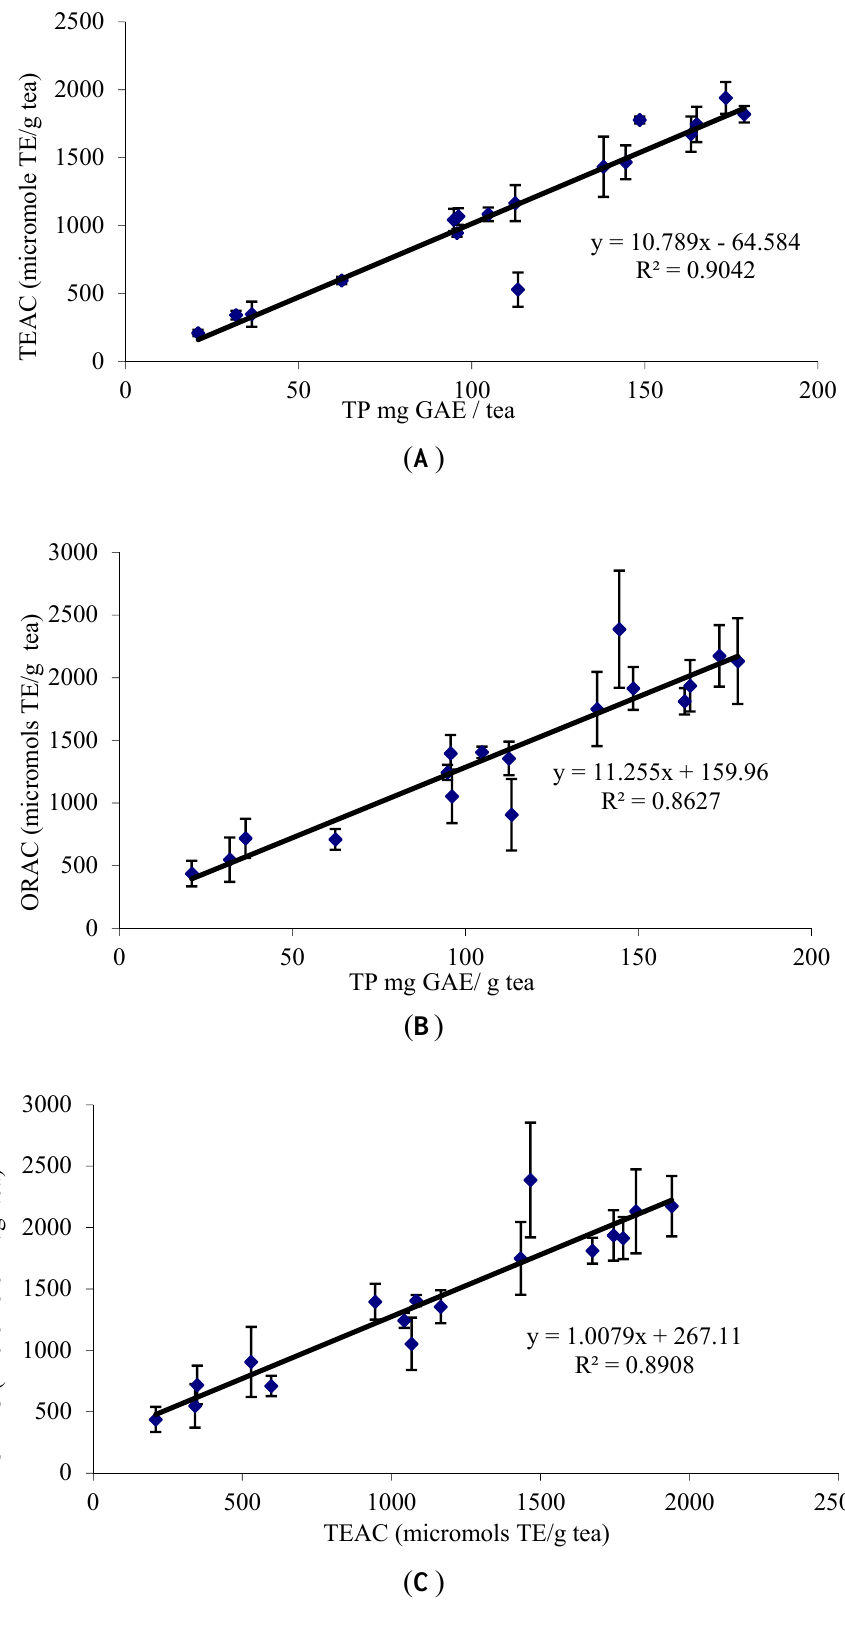
Figure 2. Correlation between TEAC, ORAC and total polyphenols (TP). ( A ) Correlation between TEAC and TP, ( B ) ORAC and TP and ( C ) ORAC and